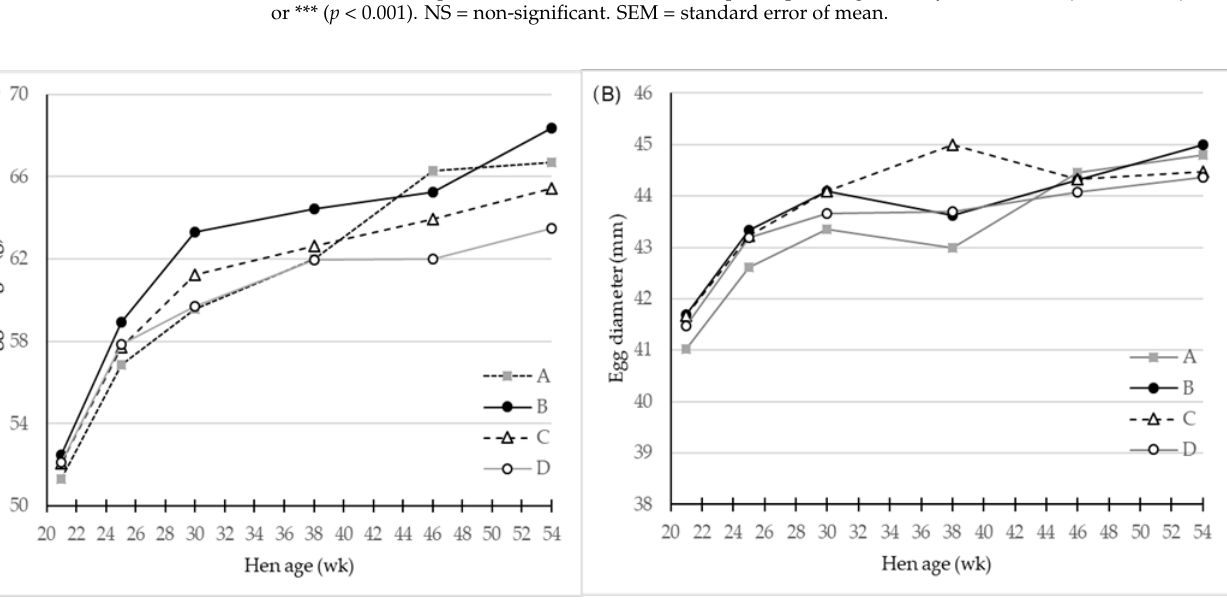
Figure 1. LS-means of ( A ) Egg weight (g) and ( B ) egg diameter (mm) for eggs of four different hen genotypes A, B, C, and D as differentiated by hen age (week), n = 30 for genotype A and 45 for genotypes B, C and D. There was a significant ( p < 0.001) interaction effect of genotype and hen age on both parameters.